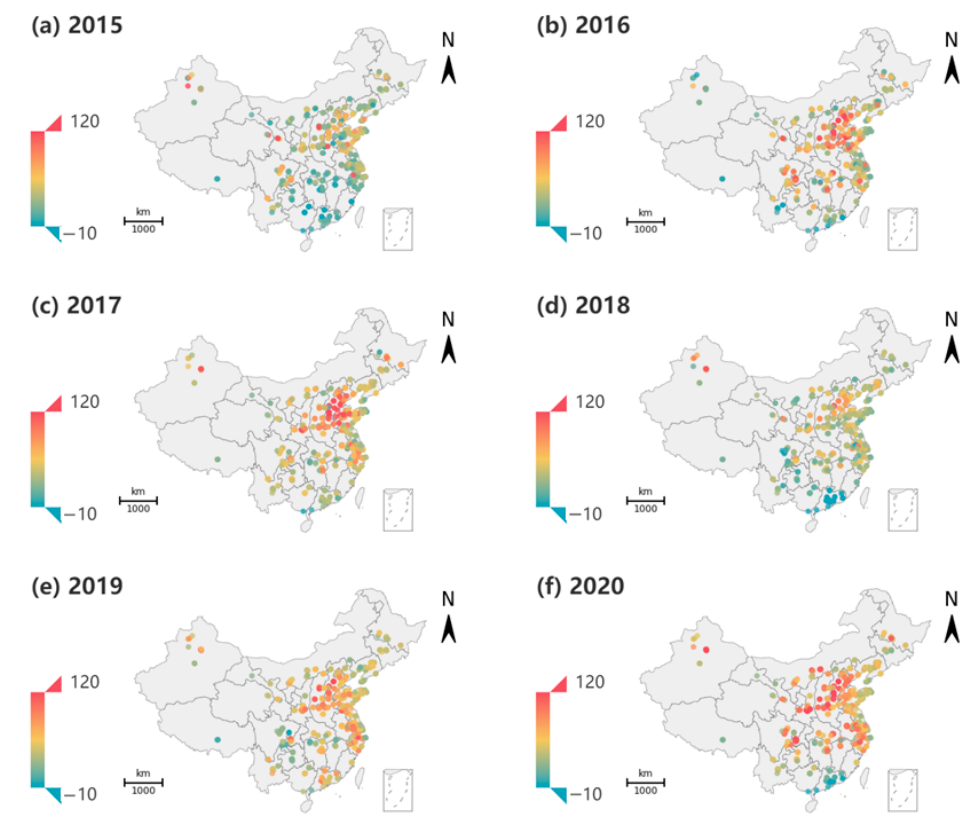
Figure 2. The spatial distribution of percentage changes of O 3 during lockdown periods relative to pre-lockdown periods in China (%, ( a – f ) are for years from 2015 to 2020).